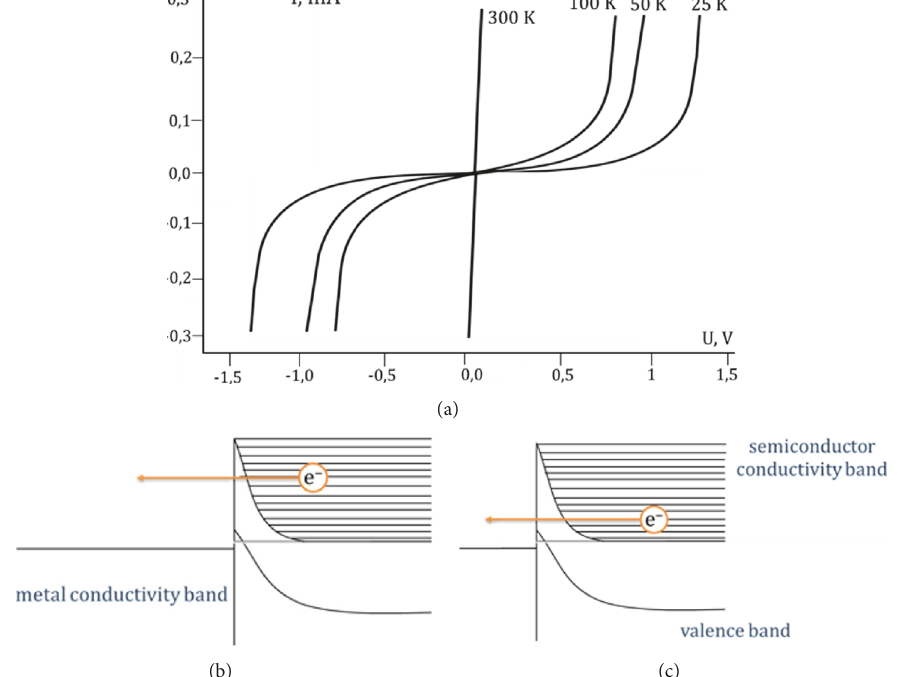
Figure 5: (a) I–V curves of SiO 2 (Ni)/Si nanosystems for different temperatures. Band structure of n -type semiconductor system, metal with a Schottky barrier: (b) at high temperatures; (c) at low